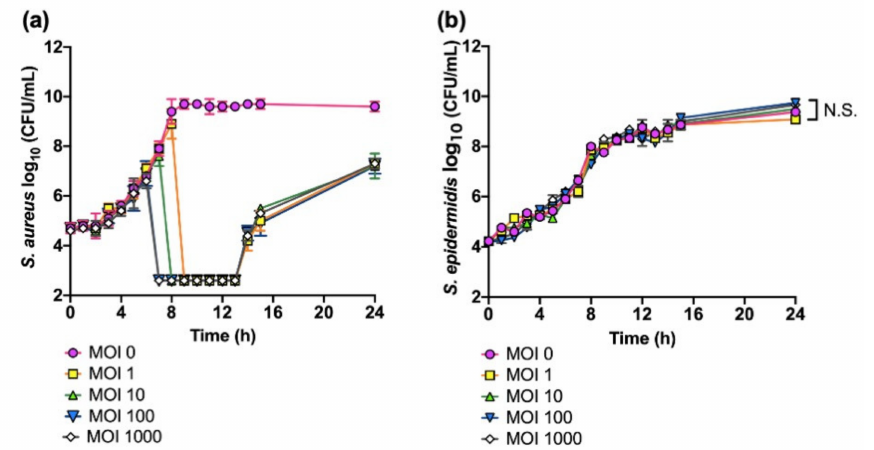
Figure 1. Killing assays of S. aureus SA-1 and S. epidermidis SE-4 treated with phage SaGU1. ( a ) S. aureus SA-1 lysis with phage SaGU1 infection. ( b ) S. epidermidis SE-4 growth in the pres- ence of phage SaGU1. The culture was started with ~10 4 CFU/mL of staphylococci and appropriate amounts of phage SaGU1. The data are presented as the mean ± SD of at least three independent experiments. The detection limit was 4.0 × 10 2 CFU/mL. Student’s t -test was used to determine a significant difference between the presence and absence of phage SaGU1. N.S.; not